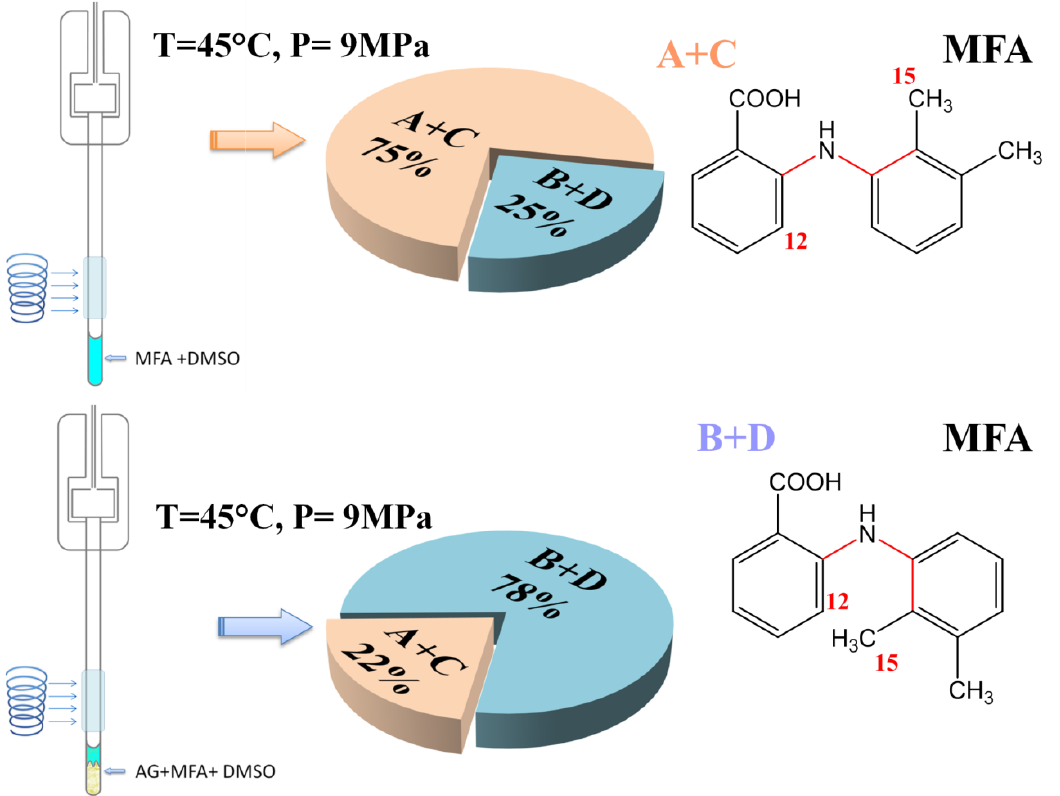
Figure 7. A schematic representation of the cell is shown on the left, with MFA solution in DMSO-d6 (86 μL) depicted in blue and MFA-doped aerogel in yellow. The center displays the distribution of mefenamic acid conformers in scCO2 by adding 2 mol.% DMSO-d6 and in scCO2 + DMSO-d6 in the presence of doped aerogel, calculated at 45 °C and 9 MPa based on the observed conformationally determined H12 – H15 distance. On the right, the structures of the predominant MFA conformers are shown, with the numbers indicating the hydrogen atoms of the conformationally defined distance— H12 – H15. The red color indicates the chemical bonds that form the dihedral angle, which alteration leads to the different conformations of the MFA molecules.